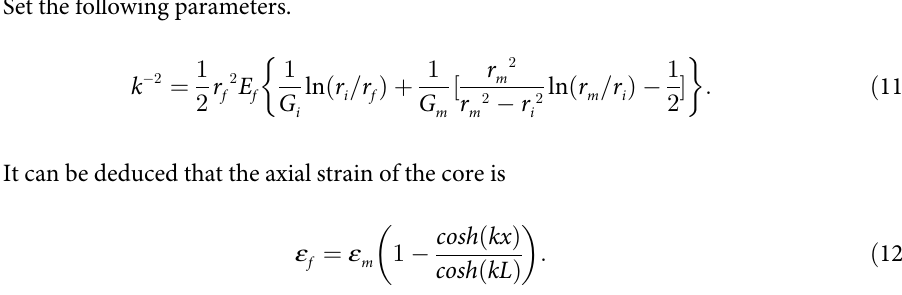
stress, τ is the shear stress, r is the radius of each layer, m is the matrix-related variable, i is the epoxy-related variable, and f is the core-related variable. Set the following parameters.